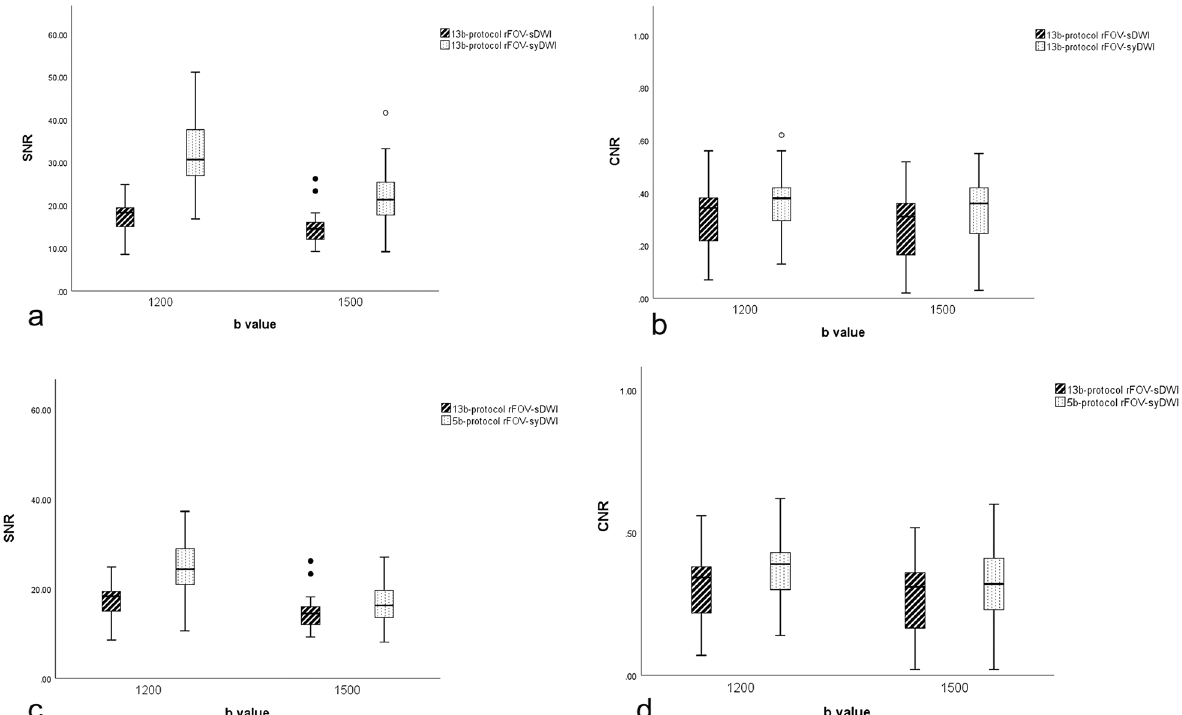
Fig. 2 Box plots illustrating the relationship between SNR ( a ) and CNR ( b ) of 13b-protocol scanned and synthetic rFOV-DWIs. And SNR ( c ), CNR ( d ) of 13b-protocol scanned and 5b-protocol synthetic